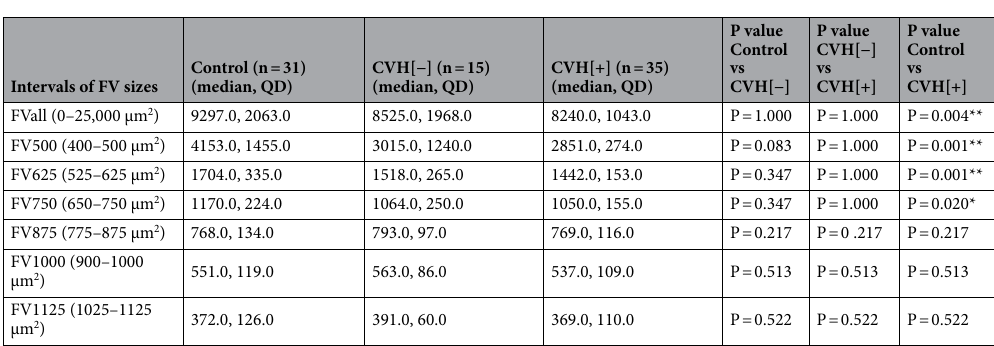
Table 4. The number of the flow void in different CVH status. QD quartile deviation, FV choriocapillaris flow void, Control age-matched control group, CVH[−] PCV fellow eyes without choroidal vascular hyperpermeability, CVH[+] P CV fellow eyes with choroidal vascular hyperpermeability. Independent-Samples Median Test, adjusted by the Bonferroni correction. *P < 0.05, **P < 0.01.